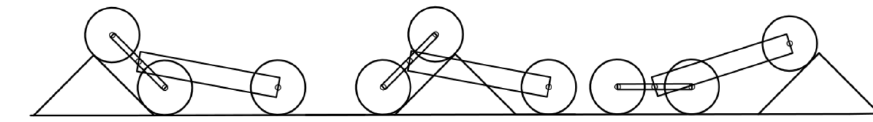
Figure 7. The three wheels on the left side of the robot cross the uneven ground in turn.